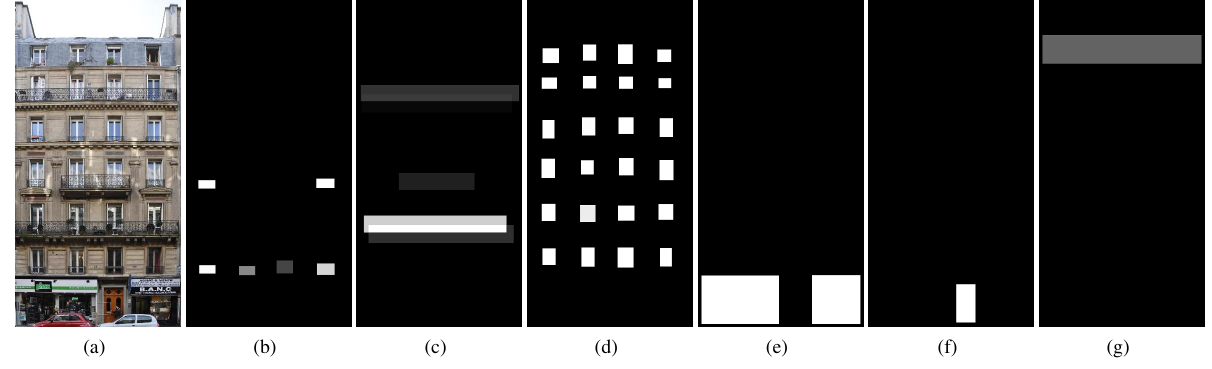
Figure 2. Region Proposal Network (RPN). The output of the RPN for the facade objects in image (a) for (b) balconies, (c) long balconies, (d) windows, (e) shops, (f) doors and (g) roof. The intensity represents the confidence of the network in the existence of an object at that position. The brighter the region, the higher is the probability of the existence of the object.